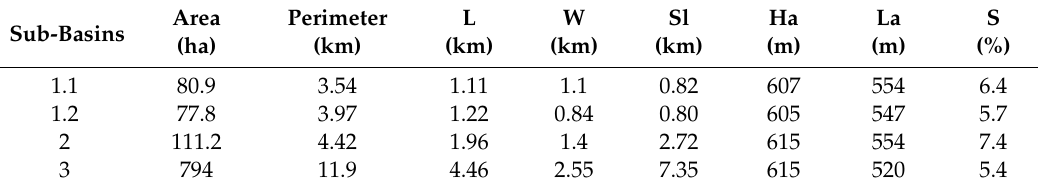
Table 2. Morphometric characteristics of sub-basins at the Olaria stream